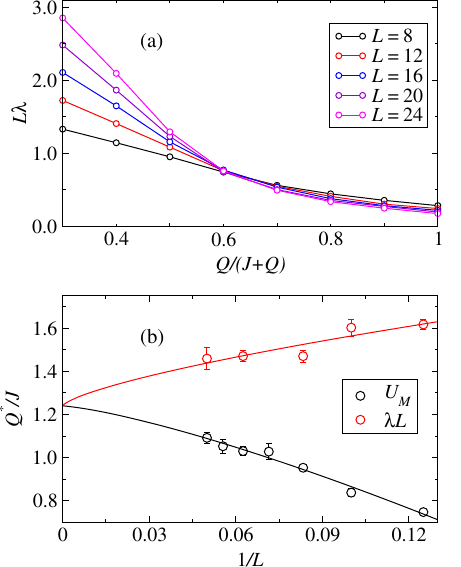
FIG. 11. (a) String fraction multiplied by L vs the coupling ratio Q= ð J þ Q Þ of the random- Q model for several system sizes. In (b), crossing points Q (cid:3) =J extracted from system size pairs ð L; 2 L Þ of data sets such as those in (a) are graphed vs the inverse system size, along with crossing points extracted from the Binder cumulant U in Fig. 9(a). The curves are fits to a common M =J ¼ 1 . 24 (cid:2) 0 . 13 ) with corrections constant (the critical value Q c ∝ L − ω , where ω ≈ 1 . 4 and 0.8 for the U and λ L crossings, M